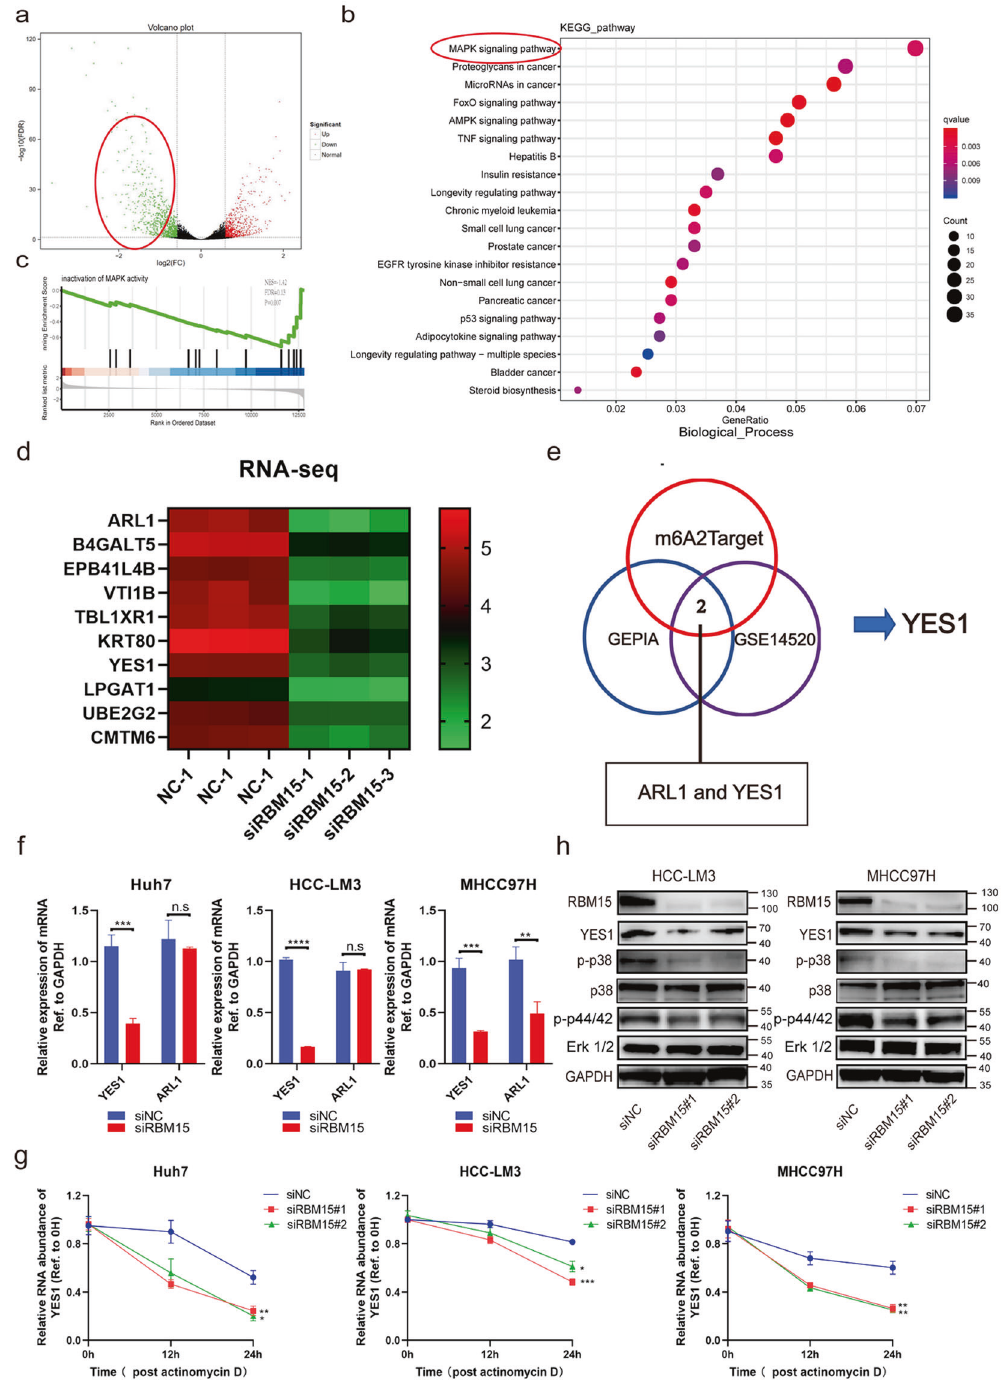
Fig. 4 RBM15 modulates the MAPK pathway via the candidate target YES1. a Volcano plot of RNA-sequencing showed the distribution of differentially expressed genes. In order to investigate the carcinogenicity of RBM15, we focused on the downregulated genes when RBM15 was silenced (marked with red circle); b KEGG pathway enrichment analysis of downregulated DEGs indicated that RBM15 may promote HCC tumorigenesis via the MAPK signaling; c GSEA analysis showed that downregulated DEGs were enriched in the inactivation of MAPK activity; d heatmap of the top ten downregulated genes that were closely associated with RBM15; e a Venn diagram was generated for these ten genes to verify the expression levels in GEPIA database and GSE14520 and to predict potential m6A modi fi cation of these candidates in m6A2Target database. Finally, two genes (ARL1 and YES1) were selected according to the overlaps; f RT-qPCR was conducted in Huh7, HCC- LM3, and MHCC97H cells with RBM15 silencing to validate the overlapped genes (** p < 0.01, *** p < 0.001, **** p < 0.0001; t test); g the RNA decay assays were performed in Huh7, HCC-LM3, and MHCC97H cells after treatment with Actinomycin D (* p < 0.05, ** p < 0.01, *** p < 0.001; two-way ANOVA); h expression of YES1 and downstream hub proteins in the MAPK pathway were evaluated by western blotting when RBM15 was silenced in HCC-LM3 and MHCC97H cells; the data are presented as mean ±